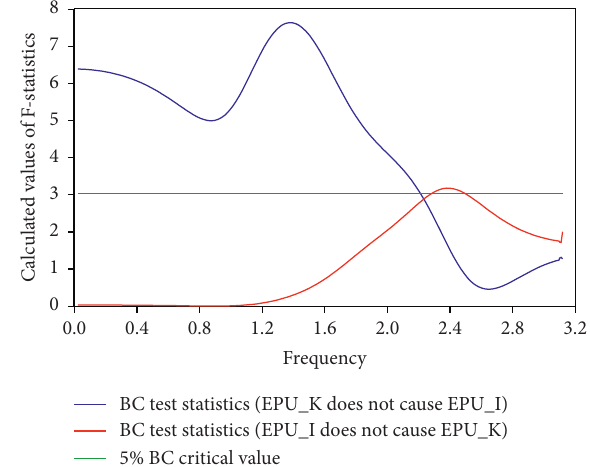
Figure 6: The frequency domain causality between Korea’s and India’s EPU indices. The part of the lines above the critical value- line indicates rejection of the null hypothesis of no Granger causality.